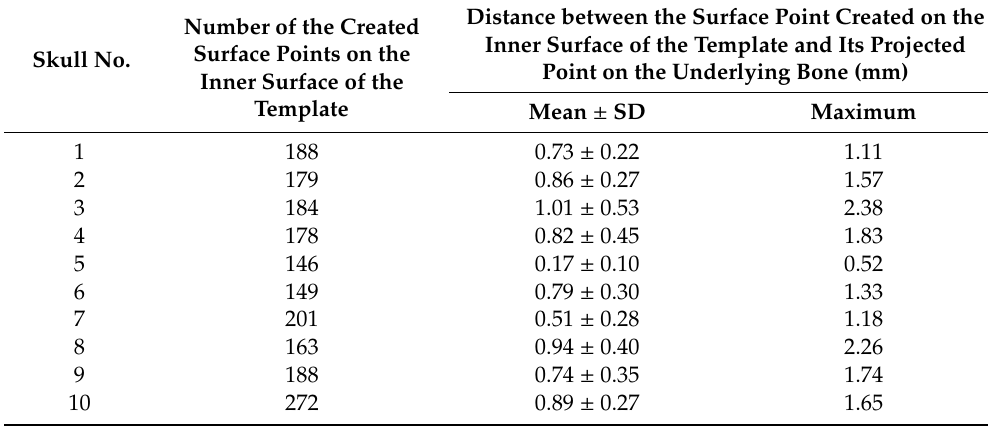
Table 3. Fitness of the surgical template for each one of the 10 dry skulls. Distance between the Surface Point Created on the Number of the Created Inner Surface of the Template and Its Projected Surface Points on the Skull No. Point on the Underlying Bone (mm) Inner Surface of the Template Mean ± SD